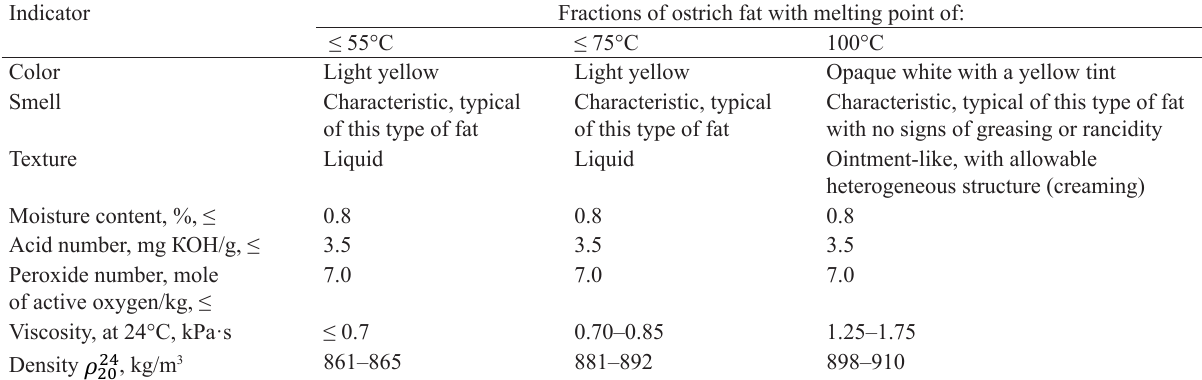
Table 8 Quality indicators of the ostrich subcutaneous fat obtained according to the developed technology Indicator Fractions of ostrich fat with melting point